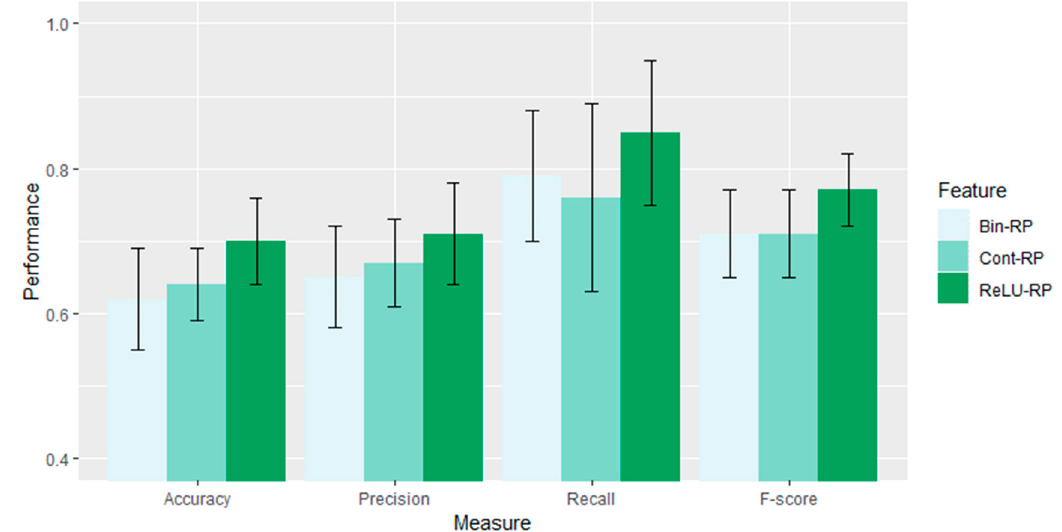
Figure 10. Comparison of the drowsiness detection performance of Bin-RP vs. Cont-RP vs. ReLU-RP using ECG. Table 3. Drowsy/awake classification performance using ECG strap signals; performance measures were calculated based on 10-fold cross-validation. LR—logistic regression; KNN—K-nearest neighbor; SVM—support vector machine; and RF—random forest.